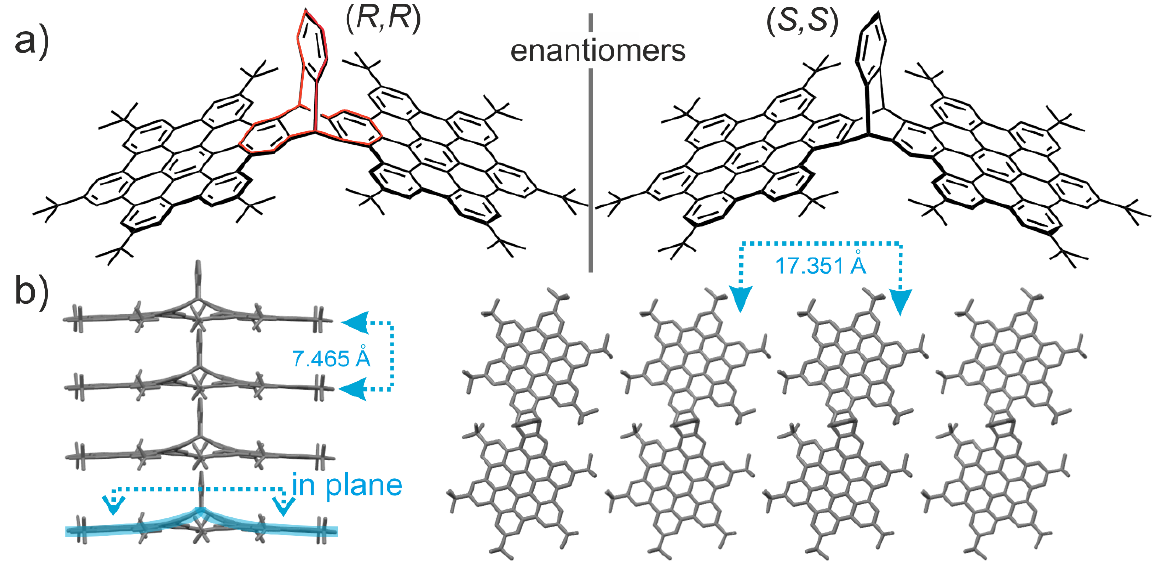
Figure 8. ( a ) The ( R , R ) and ( S , S ) enantiomers of the exaphenylbenzene triptycene derivative; ( b ) molecular arrangement of the ( S , S ) enantiomer in the crystal [138].